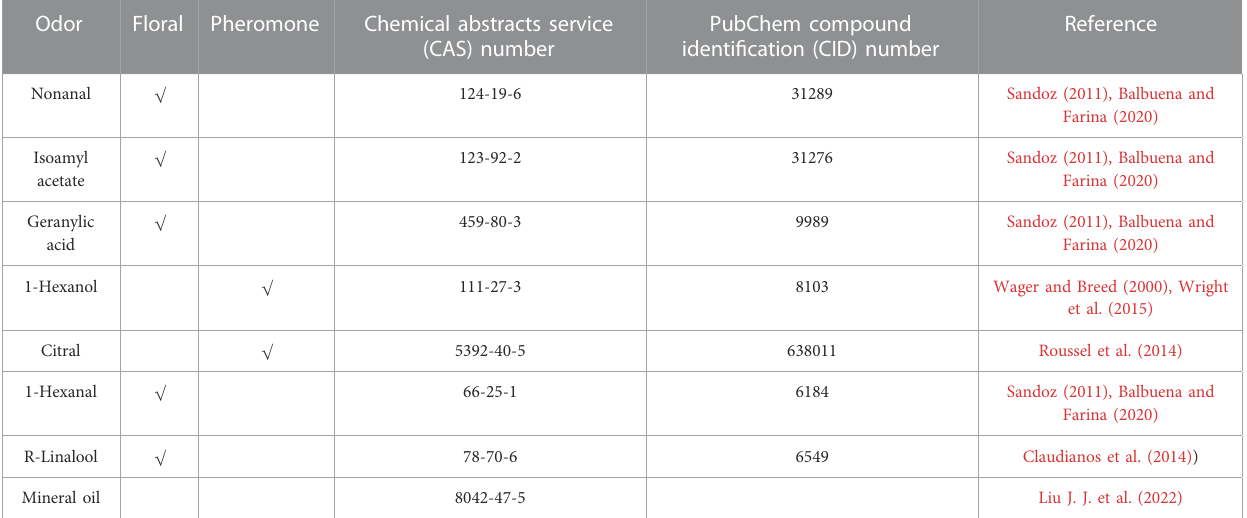
TABLE 1 Registration information for the odor stimuli used in the